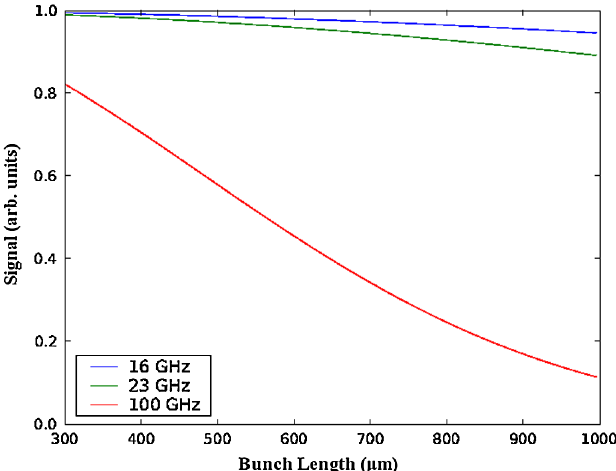
FIG. 7. (Color) The expected amplitude of the rf emitted from the ceramic gap for the range of bunch lengths possible in